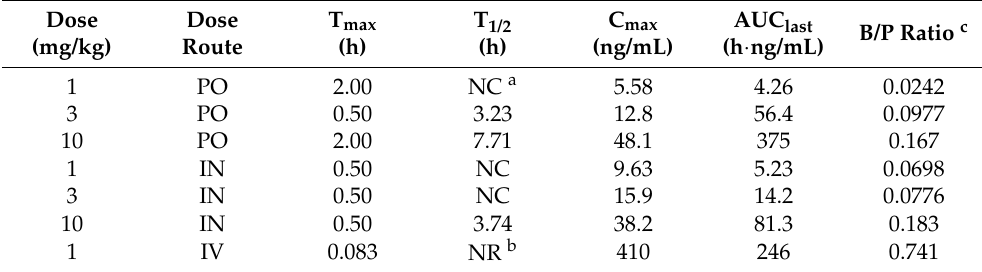
Table 5. Pharmacokinetic parameters and brain/plasma ratio of 11o in mouse brain.